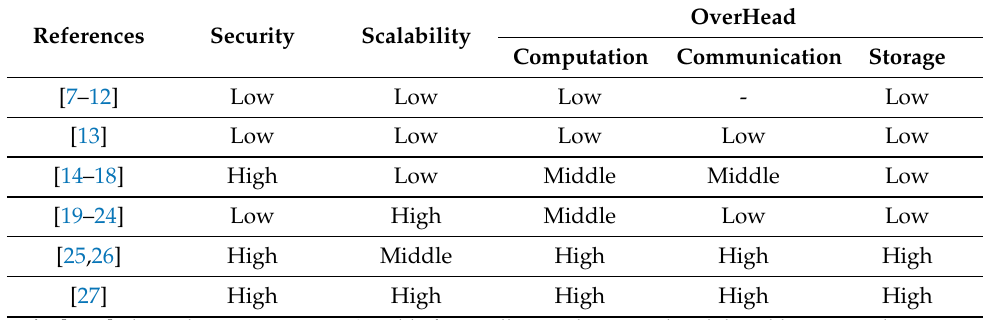
Table 1. Performance comparison of network reconfiguration